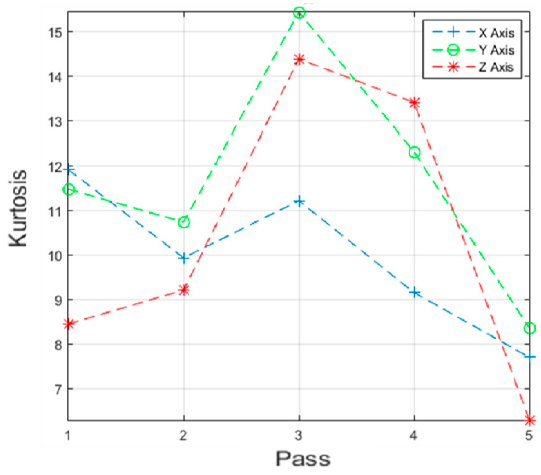
Figure 9. Kurtosis vs. number of passes.